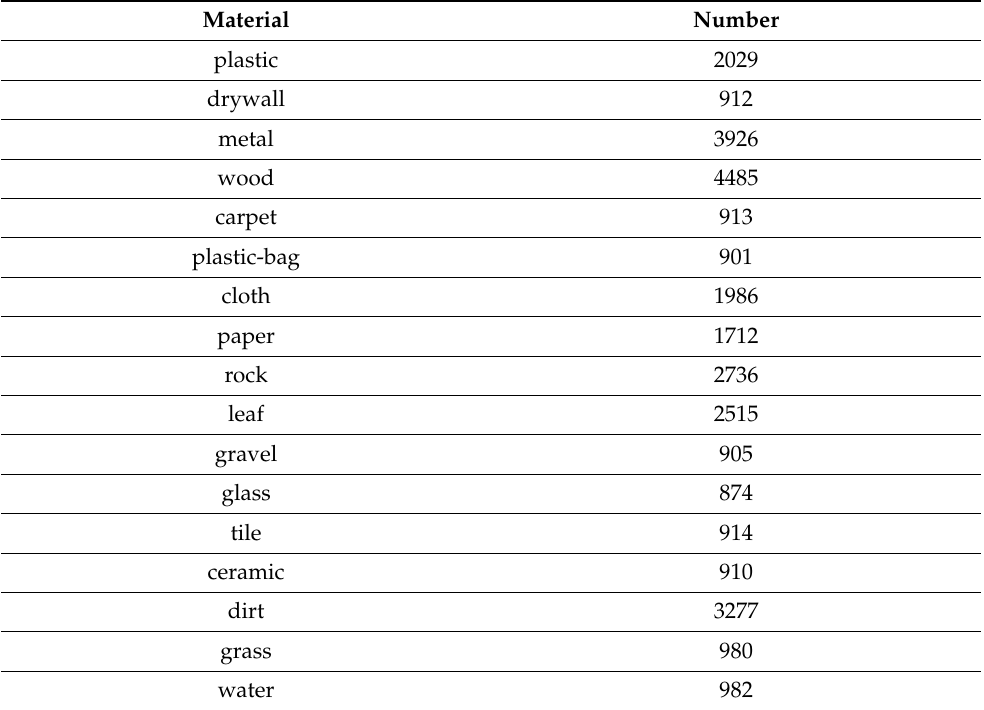
Table 1. Number of image data for each material